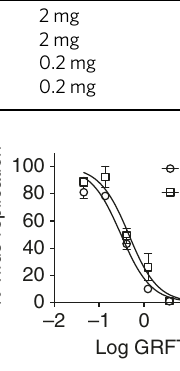
Fig. 2 Effect of semen on GRFT anti-HIV activity. The antiviral activity of GRFT was determined using the TZM-bl MAGI assay with (open squares) or without (open circles) human whole semen (WS). The graph shows the percent of virus replication (symbols and error bars represent mean ± standard deviation (SD)) relative to virus control (triplicates per condition). The dose-response curves were used to estimate EC 50 values with 95% con fi dence intervals (not shown). Data are the composite of